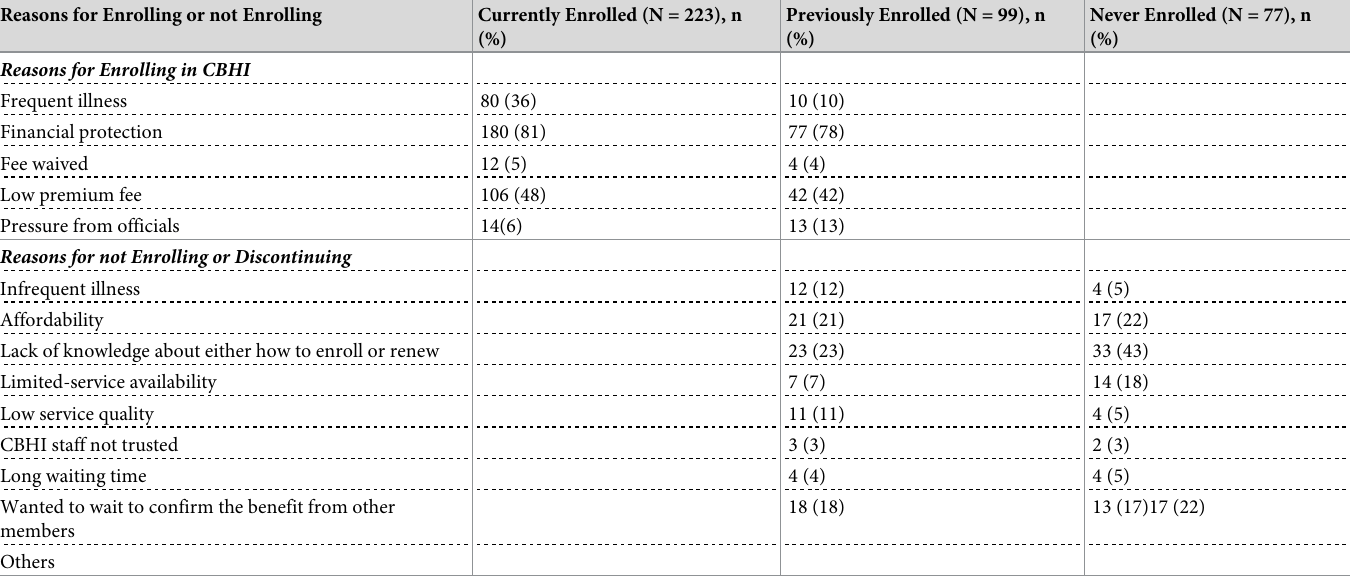
Table 5. Reasons for enrolling, discontinuing or not enrolling in CBHI scheme (%) (multiple responses). Reasons for Enrolling or not